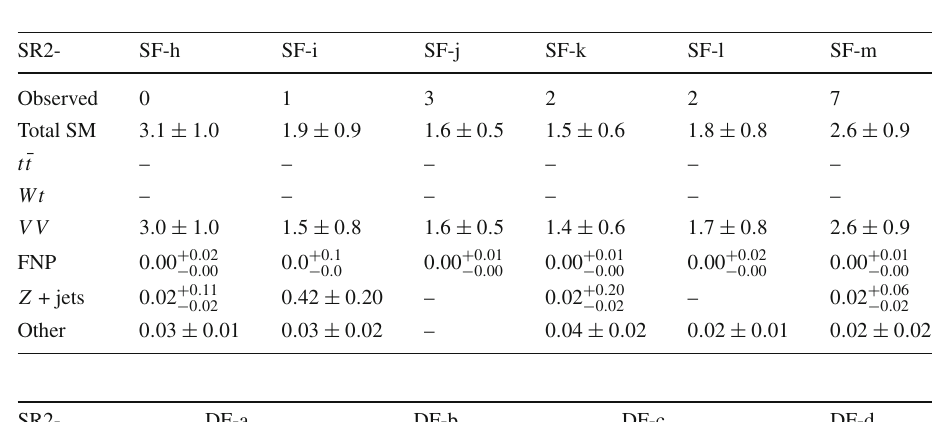
results for SR2-DF-a to SR2-DF-d in the 2 (cid:4) + 0 jets channel. All systematic and statistical uncertainties are included in the fit. The “other” backgrounds include all processes producing a Higgs boson, V V V or t ¯ tV . A “–” symbol indicates that the background contribution is